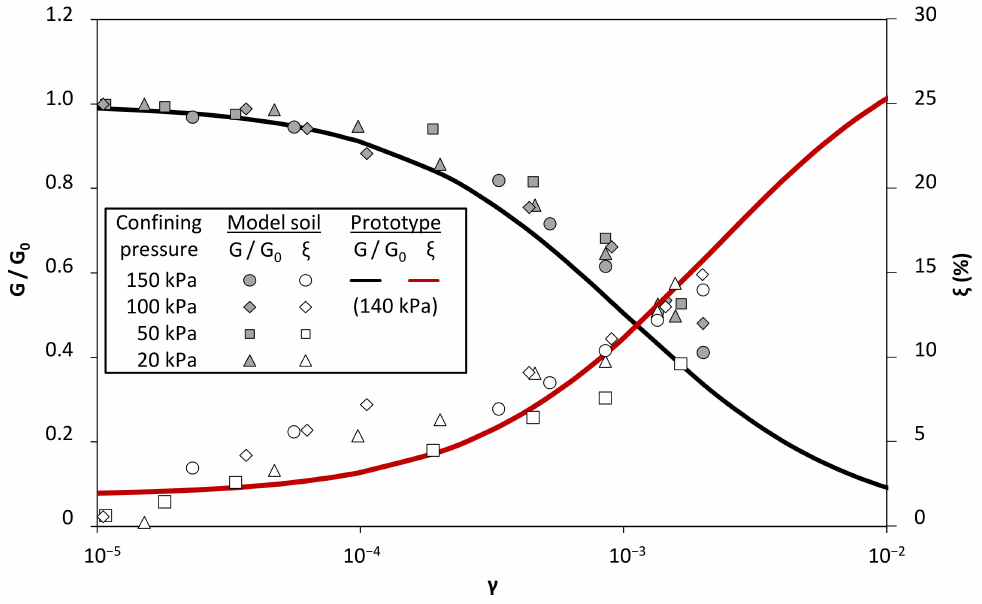
Figure 3. Comparison of the resonant column test results of the prototype (mud clay) and the synthetic model soil under confining